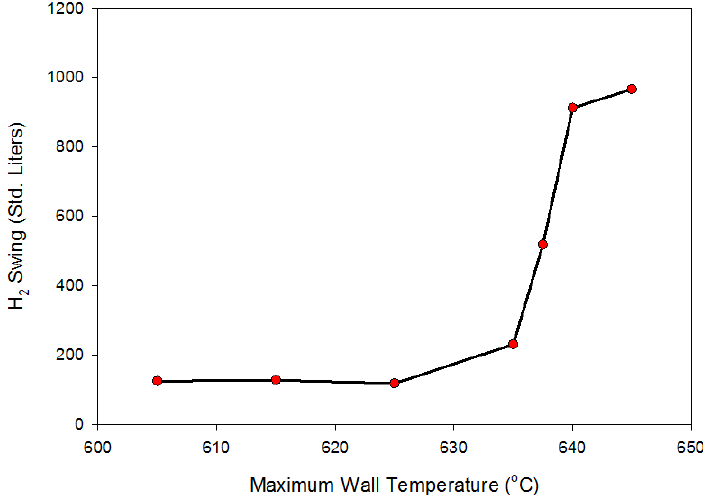
Figure 18. COMSOL model predicts the H 2 storage (in liters) for a 10-degree swing of the exterior